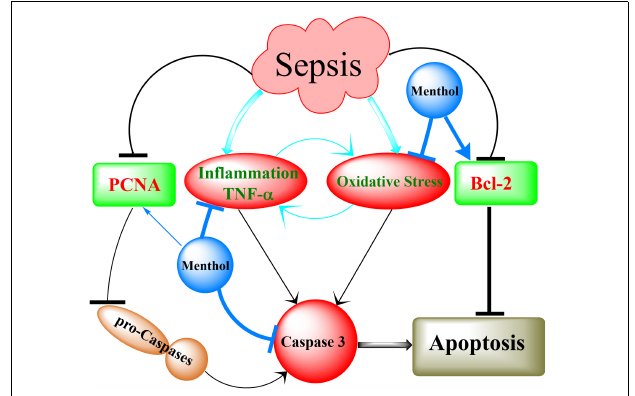
FIGURE 12 | Summary of the mechanisms involved in menthol-induced protection against sepsis. Induction of sepsis by CLP upregulates inflammation (TNF- α ) and oxidative stress, which in turn activates caspases to execute cellular apoptosis. This effect is augmented by destabilization of the antiapoptotic factor Bcl-2. Downregulation of proliferating cell nuclear antigen (PCNA) contributes to the conversion of procaspases into active caspases (Caspase 3). Menthol via inhibition of oxidative stress and inflammation on one hand, and preservation of PCNA and Bcl-2 of the other, abrogates sepsis-induced organ